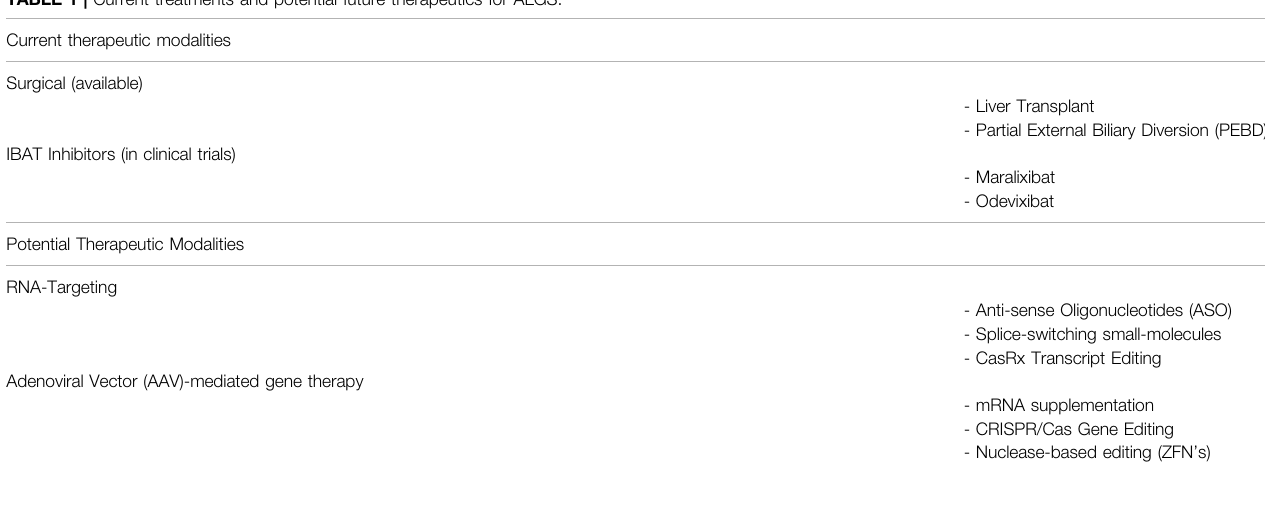
TABLE 1 | Current treatments and potential future therapeutics for ALGS. Current therapeutic modalities Surgical